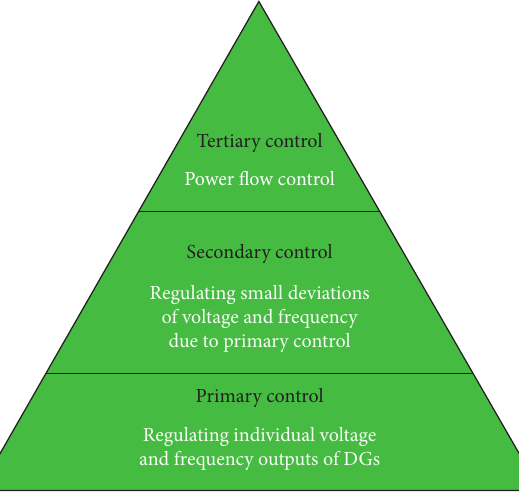
Figure 4: Representation of control hierarchy